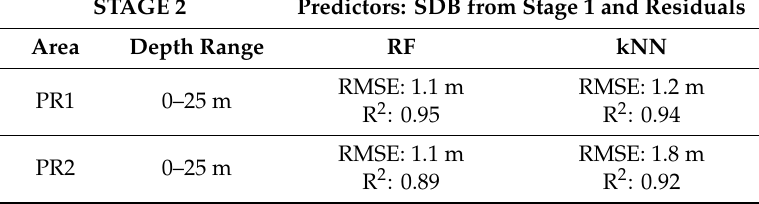
Table 3. Bathymetry prediction accuracy (RMSE and correlation coe ffi cient R 2 with reference bathymetry) for stage